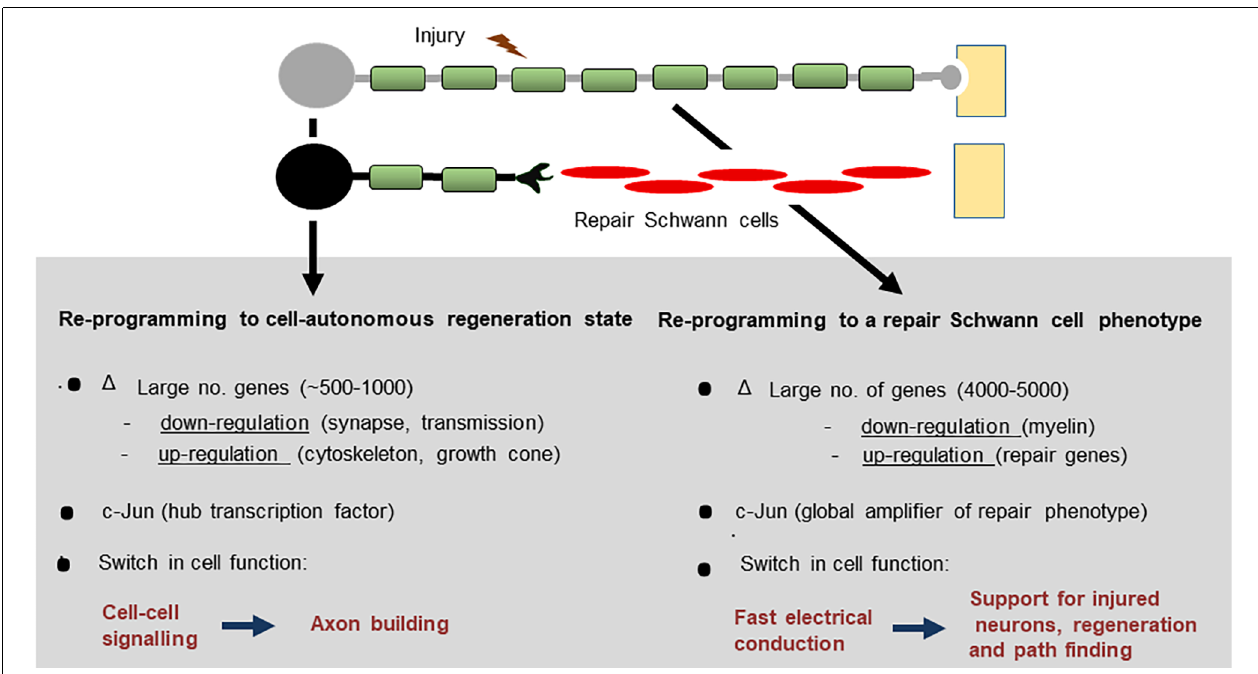
FIGURE 1 | After peripheral nerve injury, both Schwann cells and neurons change function and switch to pro-regenerative states.